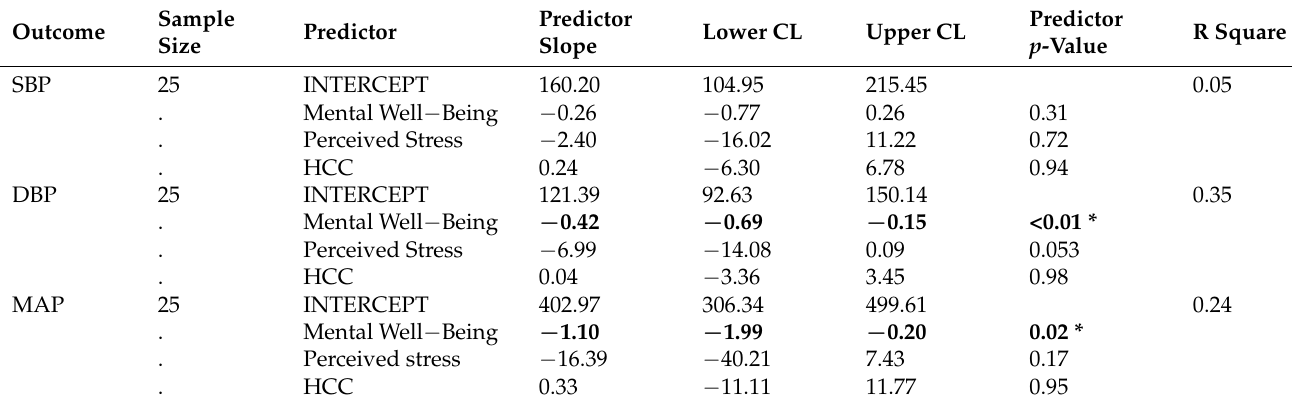
Table 3. Multiple Linear Regression Models for SBP, DBP, and